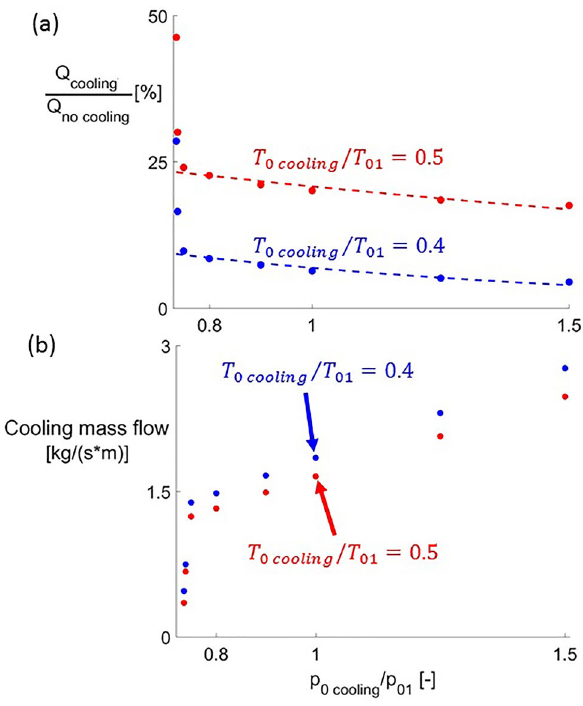
Figure 13. Thermal load alleviation ( a ) and cooling mass flow ( b ) for steady blowing